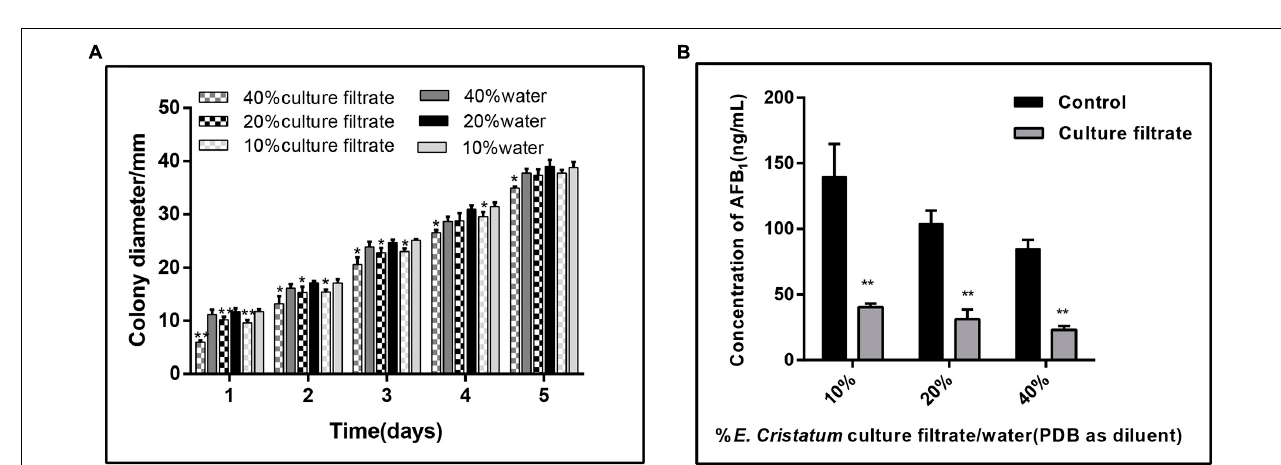
FIGURE 1 | Confronting incubation assay and growth curve for A. flavus and E. cristatum. (A) Growth curves of A. flavus and E. cristatum in PDA at 28 ± 2 ◦ C for 5 days. Data spots represent mean values of three determinations ± standard deviation. (B) A. flavus was inoculated at the center of the PDA plate and E. cristatum and sterile water (control) were inoculated at 25 mm from the center of the plate.